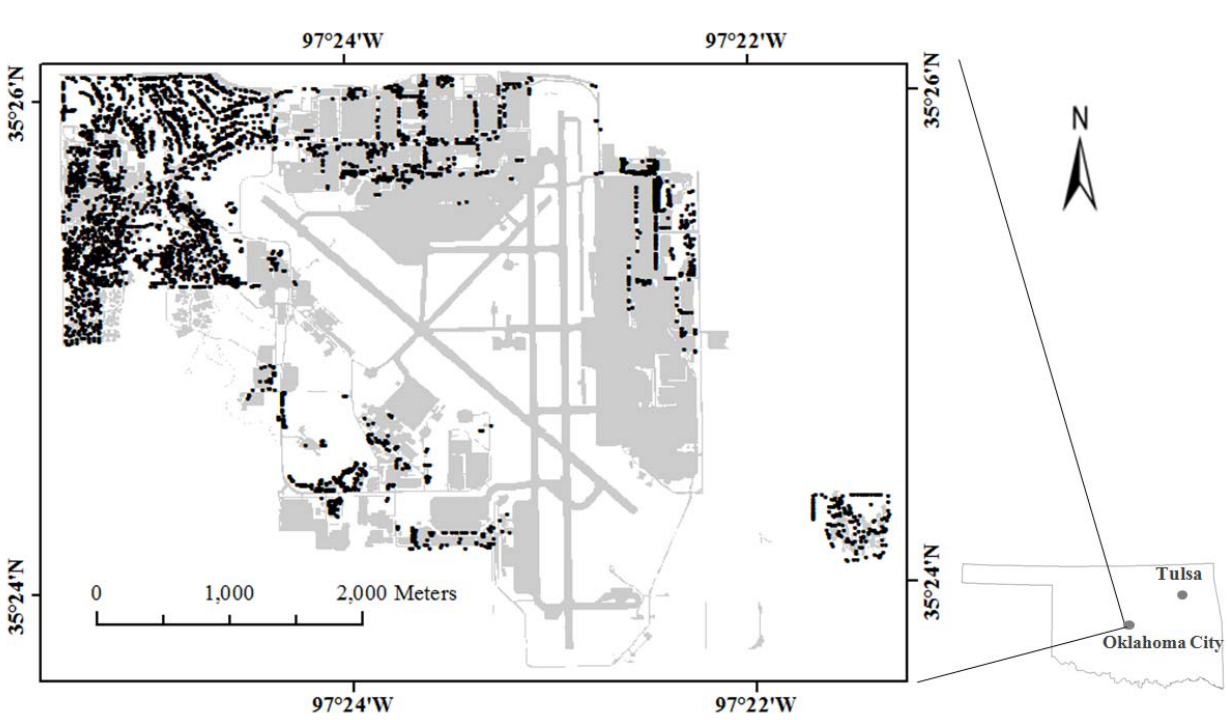
Figure 1. Study area at Tinker Air Force Base, Oklahoma. Trees measured are shown in darker